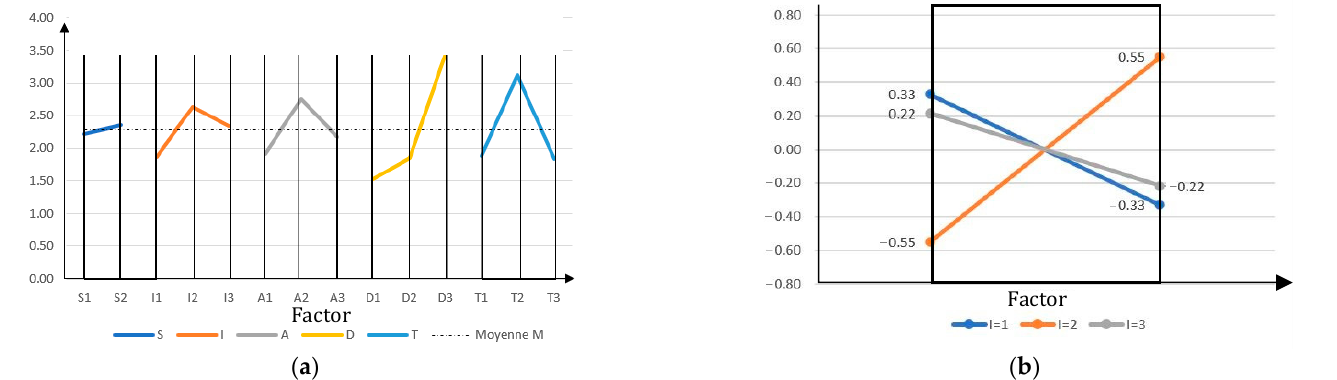
Figure 10. ( a ) Graph of factor effects. ( b ) Graph of intensity between factors S and I.